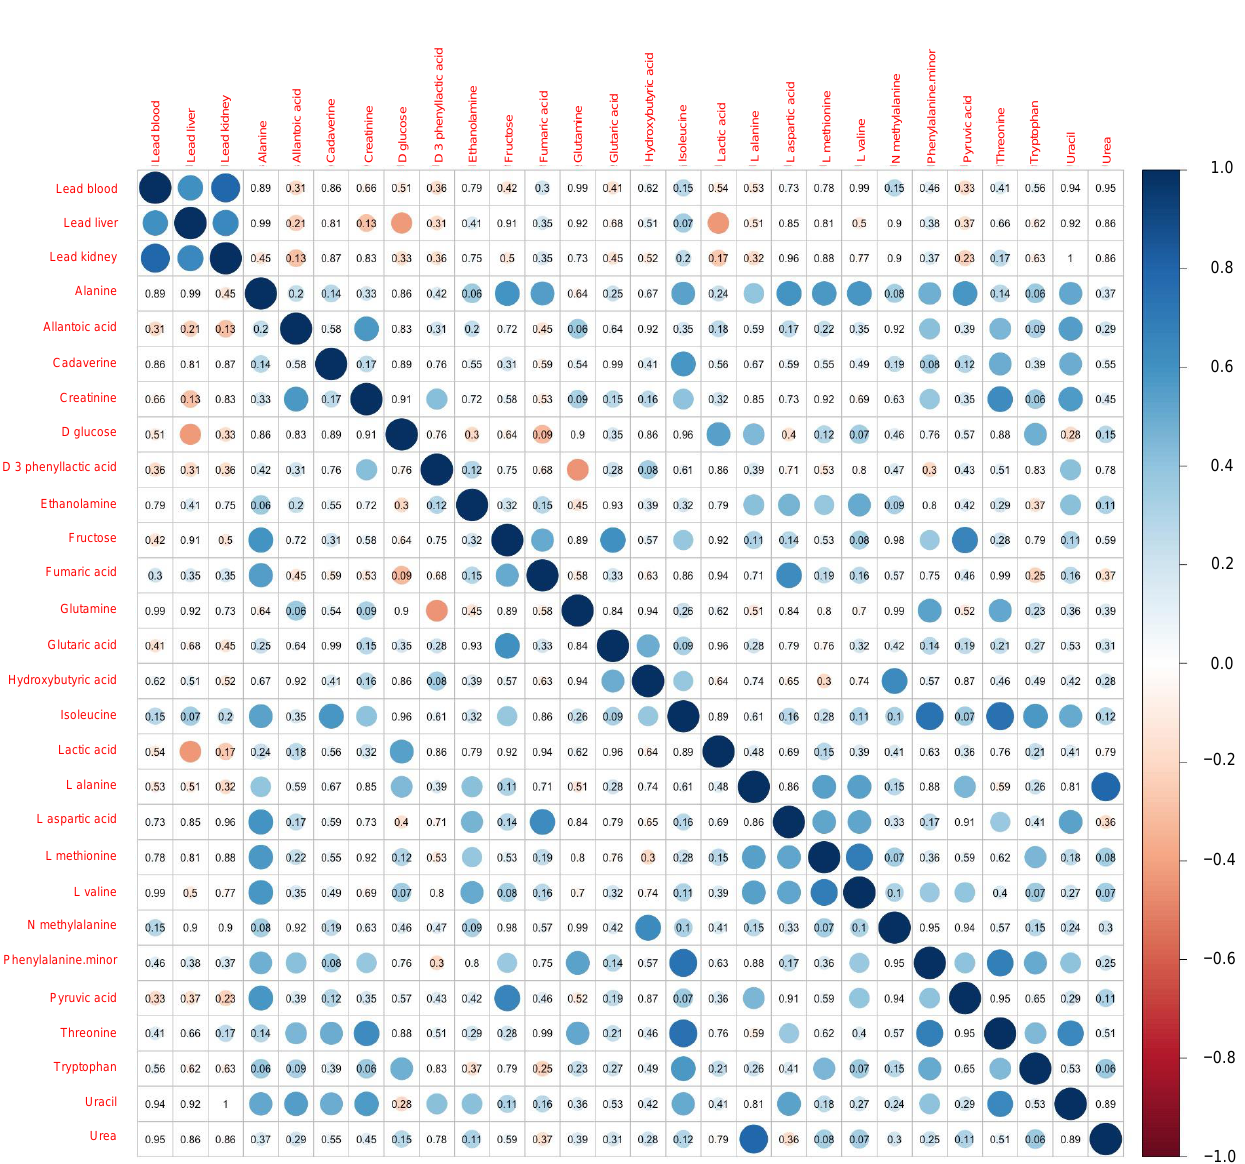
Figure 3. Correlation matrix of the levels of lead in tissue and concentration of metabolites in plasma. The number in each cell indicates the p value, and the colored circle indicates the correlation